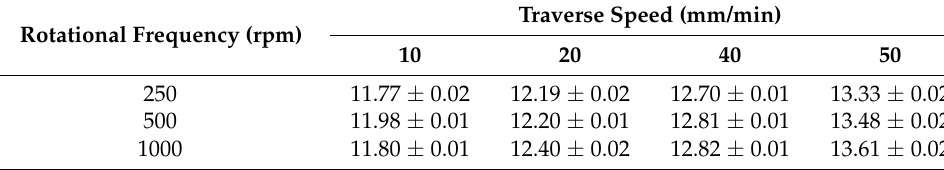
Table 5. Final diameters of the specimens (mm).